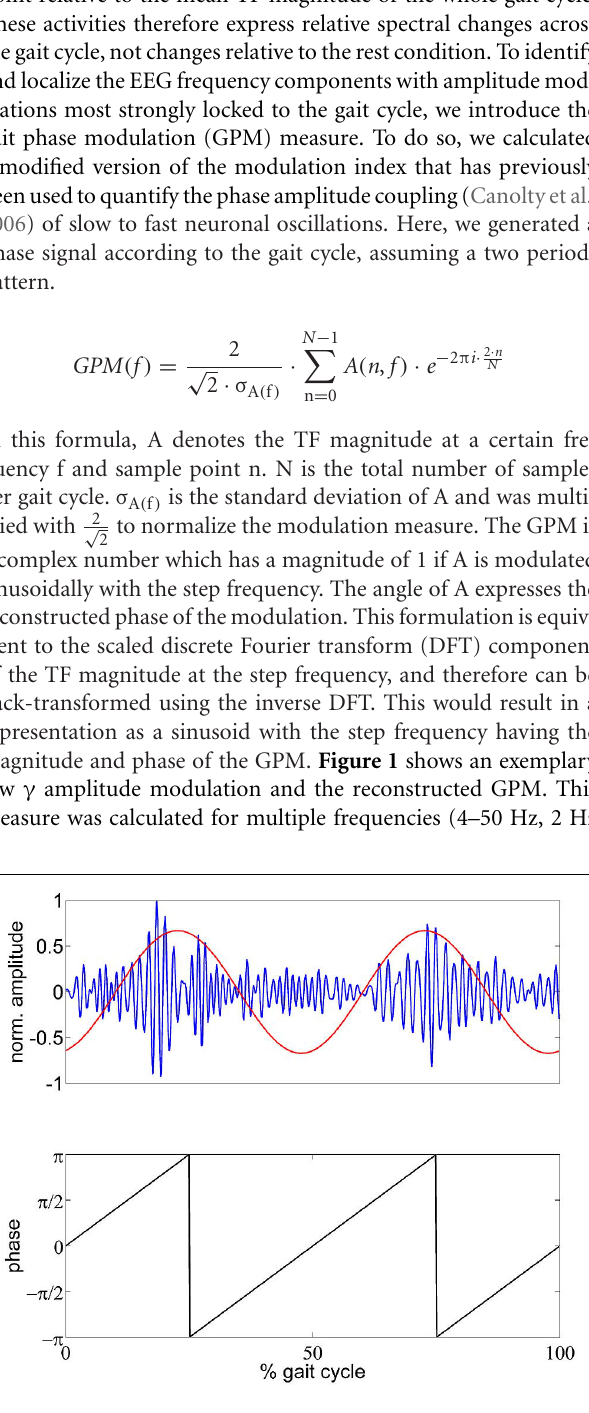
FIGURE 1 | Schematic illustration of the GPM measure. Top panel: exemplary (single trial) gait phase modulated low γ oscillation in blue and reconstructed GPM as time course. Bottom panel: generated gait phase assuming a two period pattern per gait